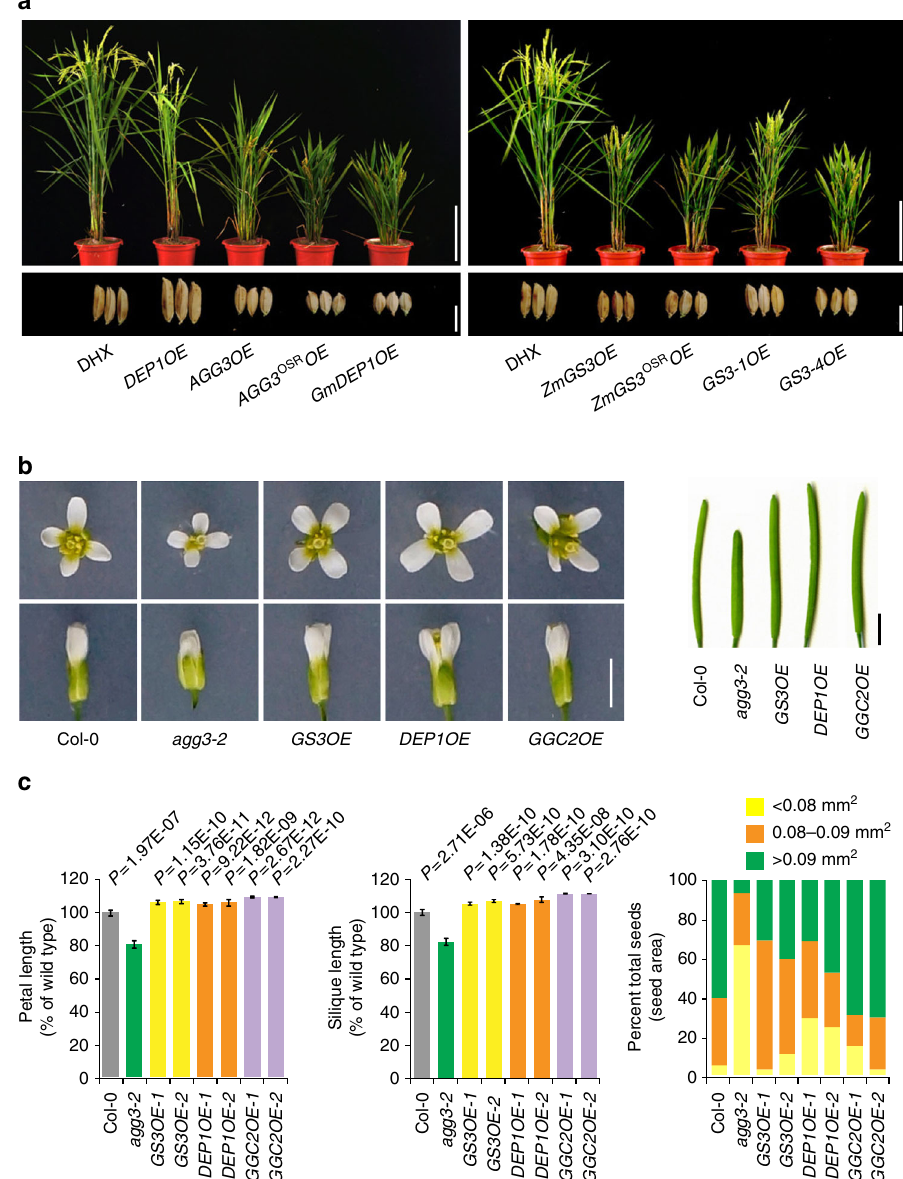
Fig. 6 The functions of three G γ proteins and their homologs in the genetic backgrounds of rice and Arabidopsis . a Whole plants and grains of DHX (wild type plants), DEP1OE , AGG3OE , AGG3 OSR OE , GmDEP1OE , ZmGS3OE , ZmGS3 OSR OE , GS3-1OE , and GS3-4OE rice plants in T 1 generation. Plant, bar = 20 cm; grains, bar = 5 mm. b Flowers and siliques of the wild type Arabidopsis strain Col-0, agg3-2 , and GS3OE , DEP1OE and GGC2OE transgenes in agg3-2 (a T- DNA mutant of AGG3 ) background. Bar = 2 mm. c Petal length, silique length, and seed area of the wild type Col-0, agg3-2 , and GS3OE , DEP1OE and GGC2OE transgenes in agg3-2 background. The fully opened fl owers were measured for the sizes of petals. Values for petal length ( n = 9) are given as mean ± SEM relative to the respective wild type values setting at 100%. Values for silique length of Col-0 ( n = 12), agg3-2 ( n = 10), GS3OE-1 ( n = 16), GS3OE-2 ( n = 13), DEP1OE-1 ( n = 14), DEP1OE-2 ( n = 11), GGC2OE -1 ( n = 10) and GGC2OE -2 ( n = 10) are given as mean ± SEM relative to the respective wild type values setting at 100%. P values are given based on two-tailed t -tests. For seed size, the seeds are classi fi ed into three groups ( < 0.08, 0.08 to 0.09, and > 0.09 mm 2 ). Values of seed areas of Col-0 ( n = 61), agg3-2 ( n = 147), GS3OE-1 ( n = 78), GS3OE-2 ( n = 74), DEP1OE-1 ( n = 96), DEP1OE-2 ( n = 90), GGC2OE -1 ( n = 68) and GGC2OE -2 ( n = 71) are expressed as a percentage of the total seed number and 12.5 μ l SYBR GreenMasterMix (Applied Biosystems) on an Applied Biosystems 7500 Real-time PCR system according to the manufacturer ’ s instructions. Data were normalized with rice ubiquitin gene (LOC_Os03g13170). Primers used for qRT-PCR analysis are listed in Supplementary Data 2. The- measurements were obtained using the relative quanti fi cation method 59 .